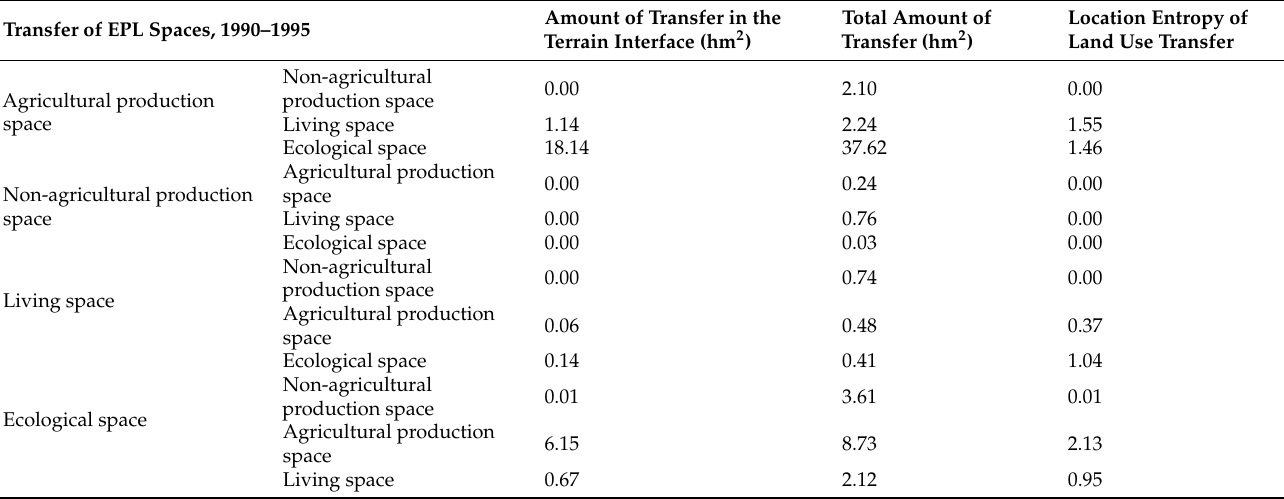
Table 4. Spatial transfer of EPL spaces in the terrain interface area from 1990 to 1995.